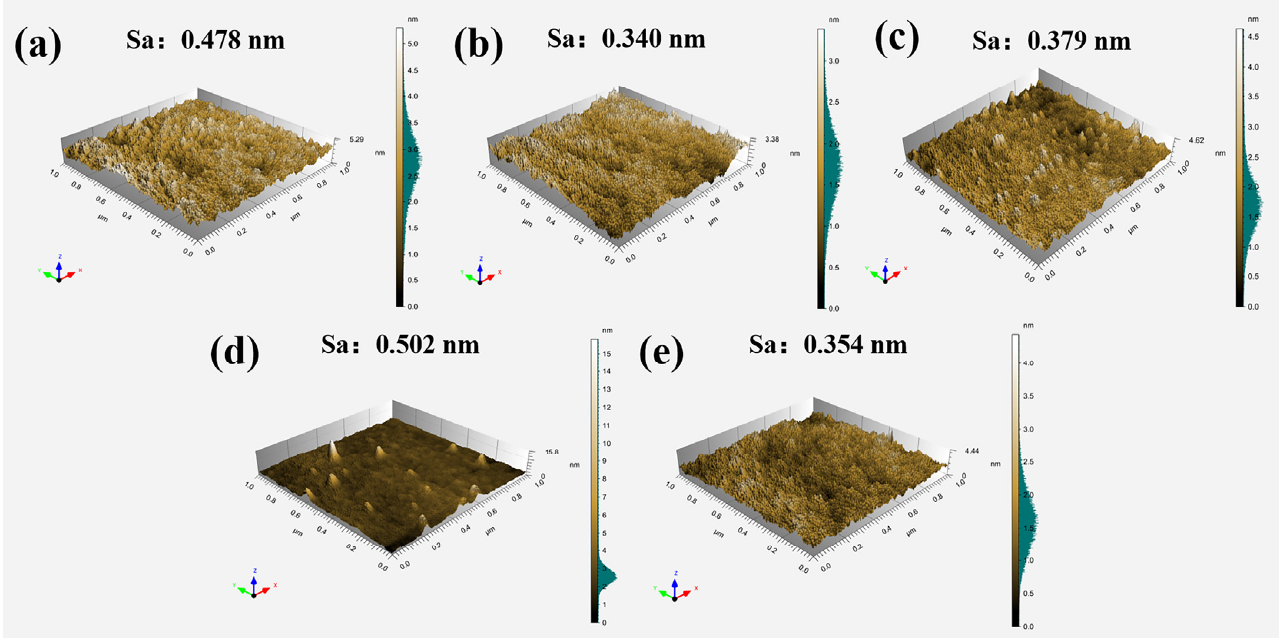
Figure 6. AFM surface morphology of 100 nm thin film: ( a ) MgO, ( b ) 1:1 Al 2 O 3 :MgO layer alternation type, ( c ) 2:1 Al 2 O 3 :MgO layer alternation type, ( d ) 3:2 Al 2 O 3 :MgO layer alternation type, and ( e ) 5:4 Al 2 O 3 :MgO layer alternation type.